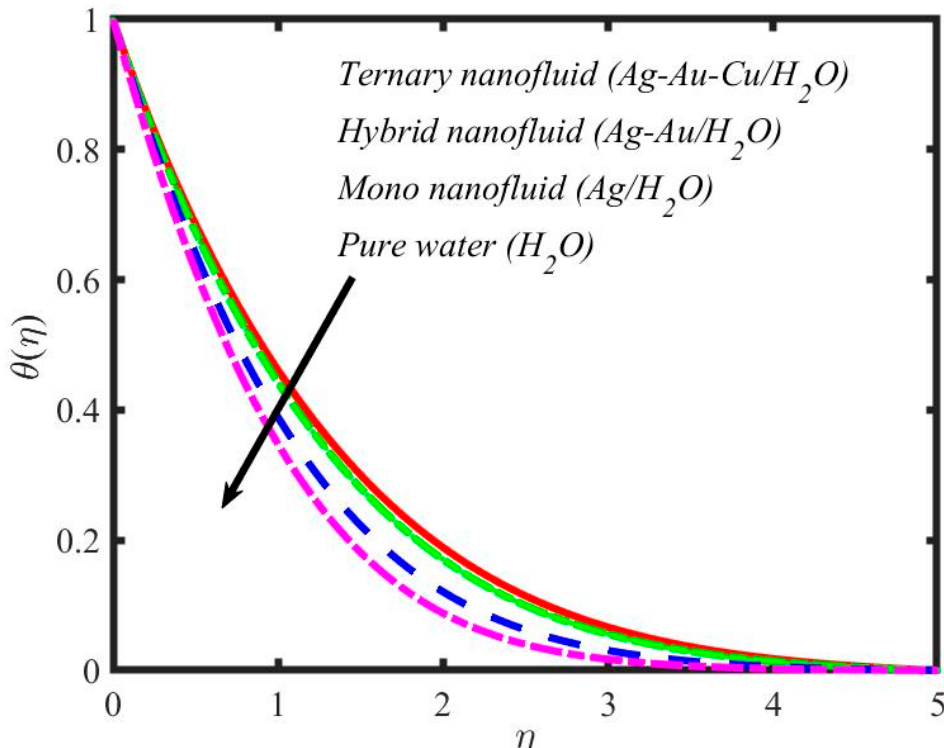
Figure 32. Variations in temperature for base, mono, hybrid and ternary nanofluids.